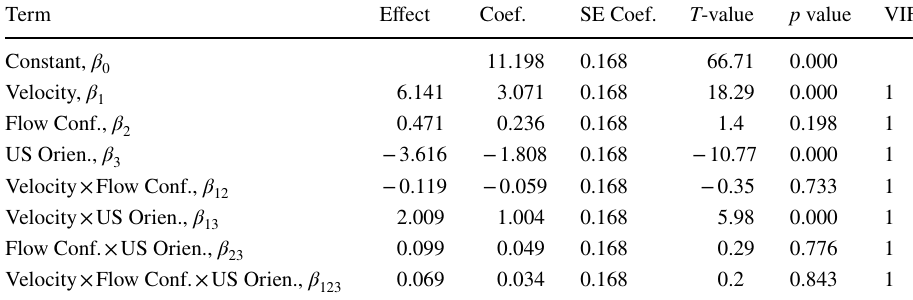
Table 5 Minitab output for the model coded coefficients for NaCl